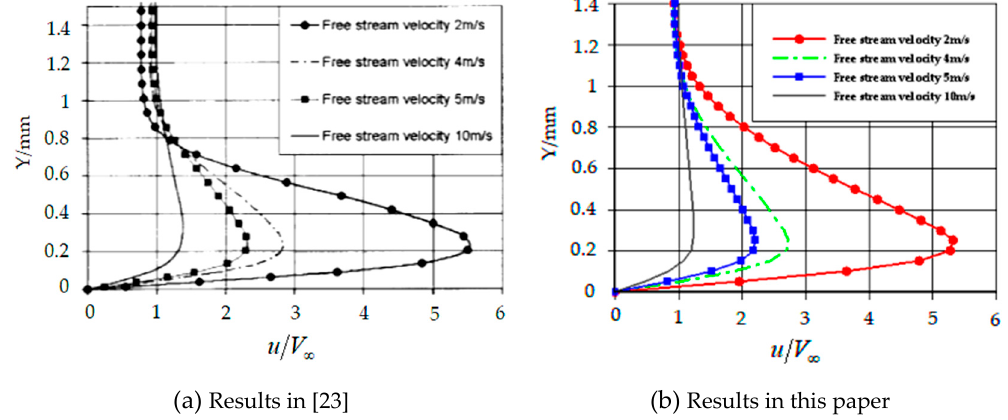
Figure 7. The velocity distribution along the y direction at 3.8 mm downstream of the upper electrode.